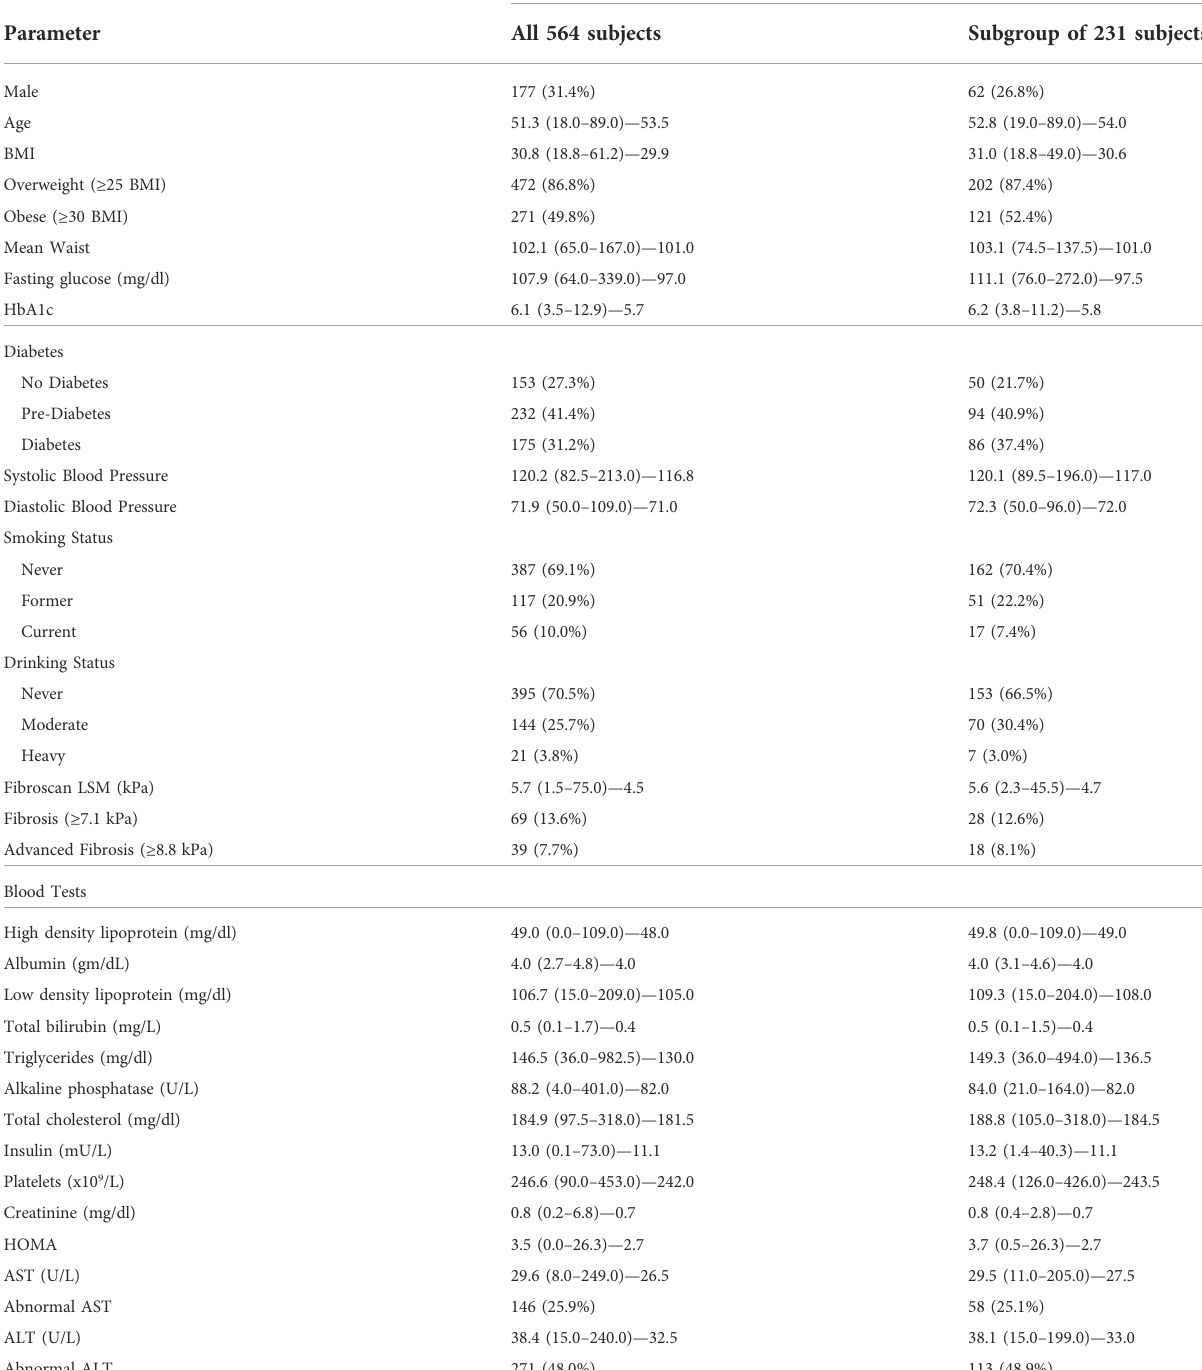
TABLE1Demographic,laboratoryandclinicalparametersofthe564CCHCsubjects.BMI:bodymassindex,HbA1c:hemoglobinA1c,CAP:controlled attenuation parameter measured by Fibroscan, LSM: liver stiffness measurement measured by Fibroscan, AST: aspartate aminotransferase, ALT: alanineaminotransferase;abnormalAST: > 33 U/L,abnormalALT: > 40 U/Lformalesand > 31 U/Lforfemales;HOMA:HomeostasisModelAssessment. Data are also shown for the subgroup of 231 CCHC subjects with 16S sequencing data